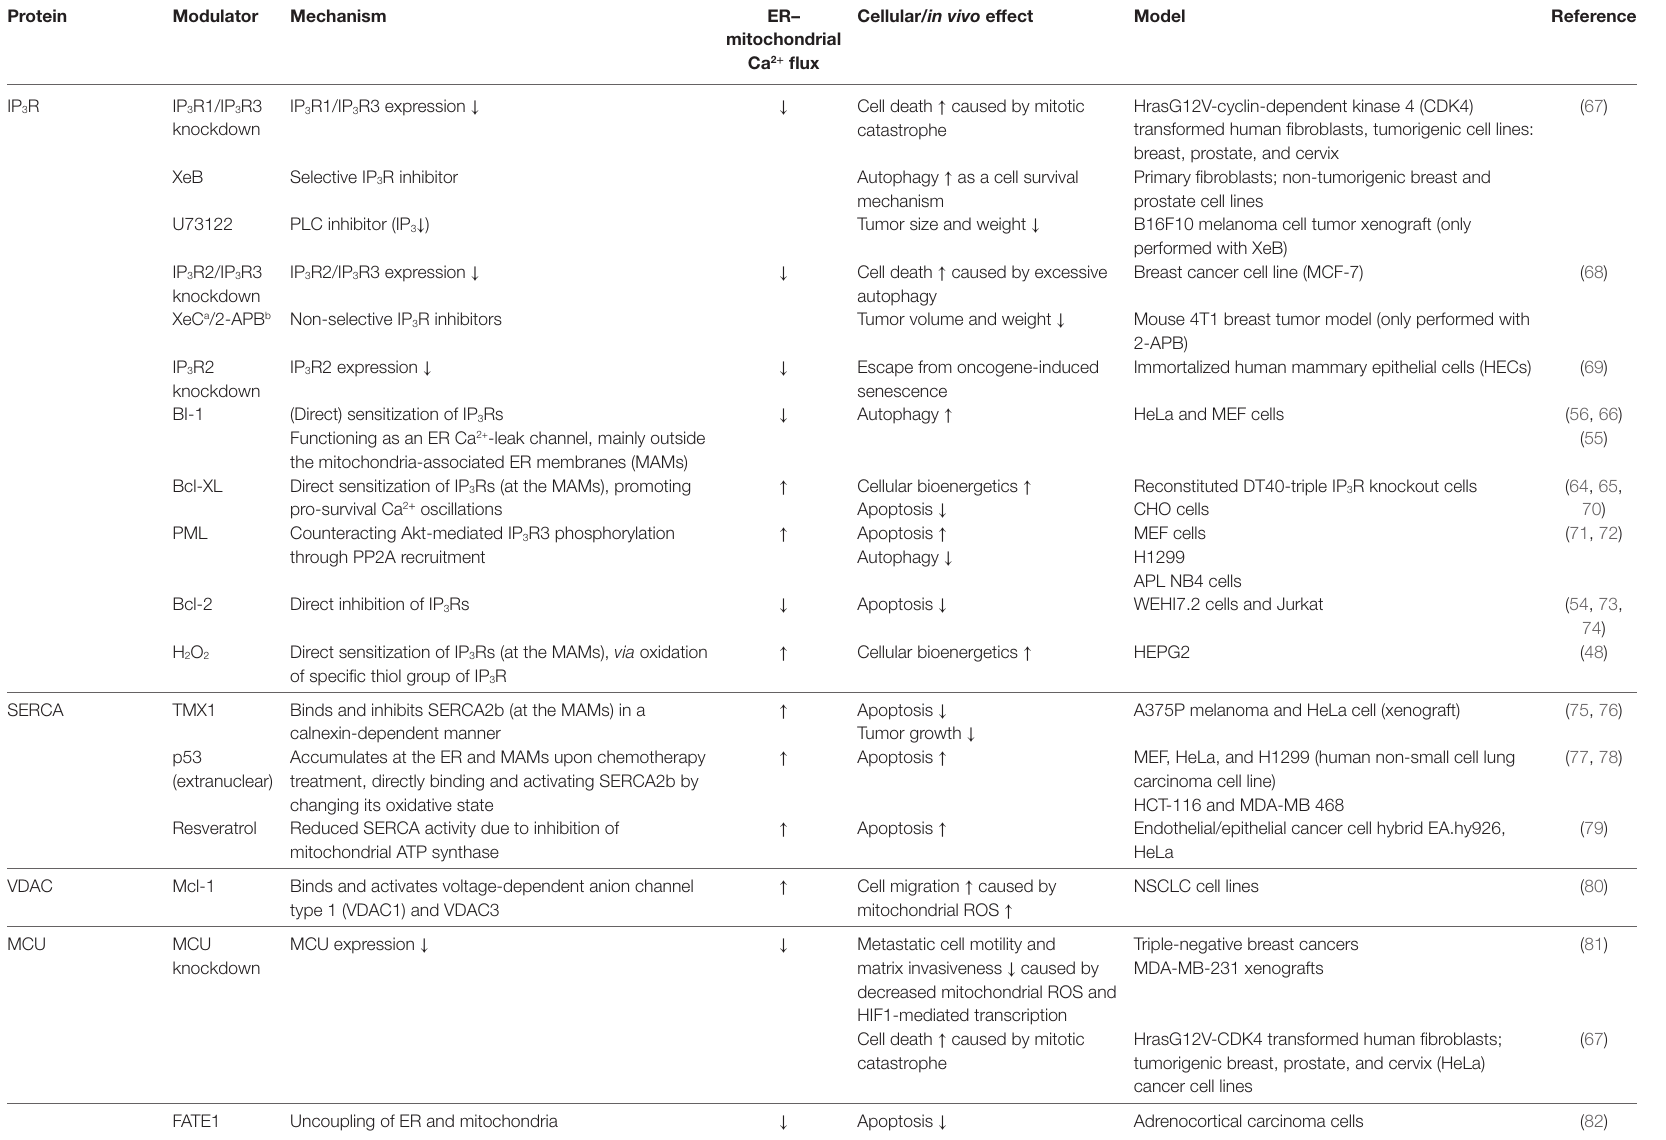
TABLe 1 | The impact of experimental, physiological, and cancer-related modulators of endoplasmic reticulum (eR)–mitochondrial Ca 2 + flux on cell death, survival, and migration.